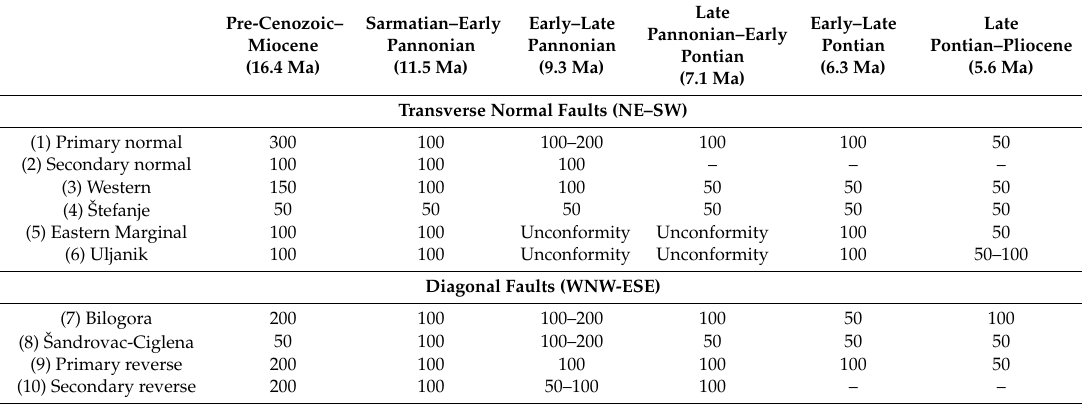
Table 1. Absolute vertical fault throws (in meters) along the main fault zone in the Bjelovar Subdepression [37].